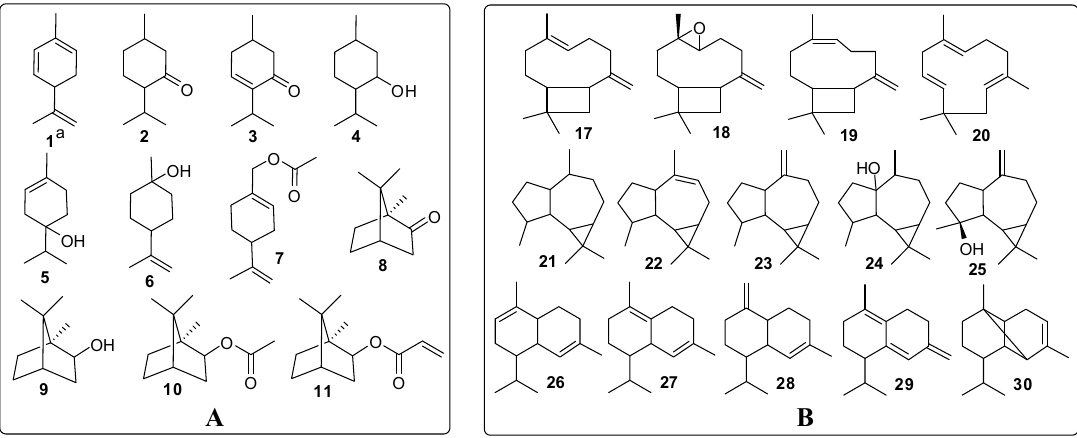
Figure 1. Main monoterpenes ( A ) and sesquiterpenes ( B ) of essential oil from L. japonicus .